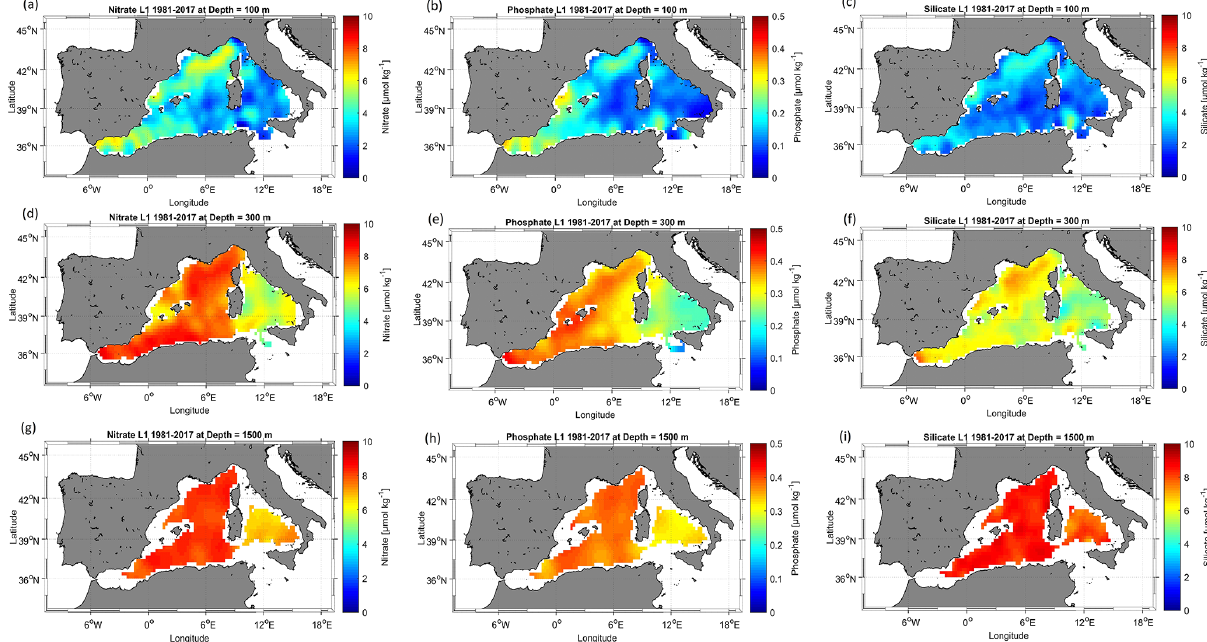
Figure 9. Climatological map distribution of nitrate ( a at 100m, d at 300m, g at 1500m), phosphate ( b at 100m, e at 300m, h at 1500m) and silicate ( c at 100m, f at 300m, i at 1500m) for the period from 1981 to 2017.